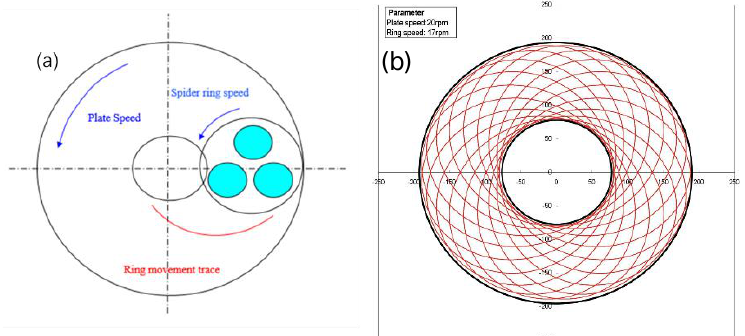
Figure 3. The scheme of the shaving process of the grinding ring: ( a ) motion model of grinding ring; ( b ) simulation diagram of the motion trajectory of the grinding ring.